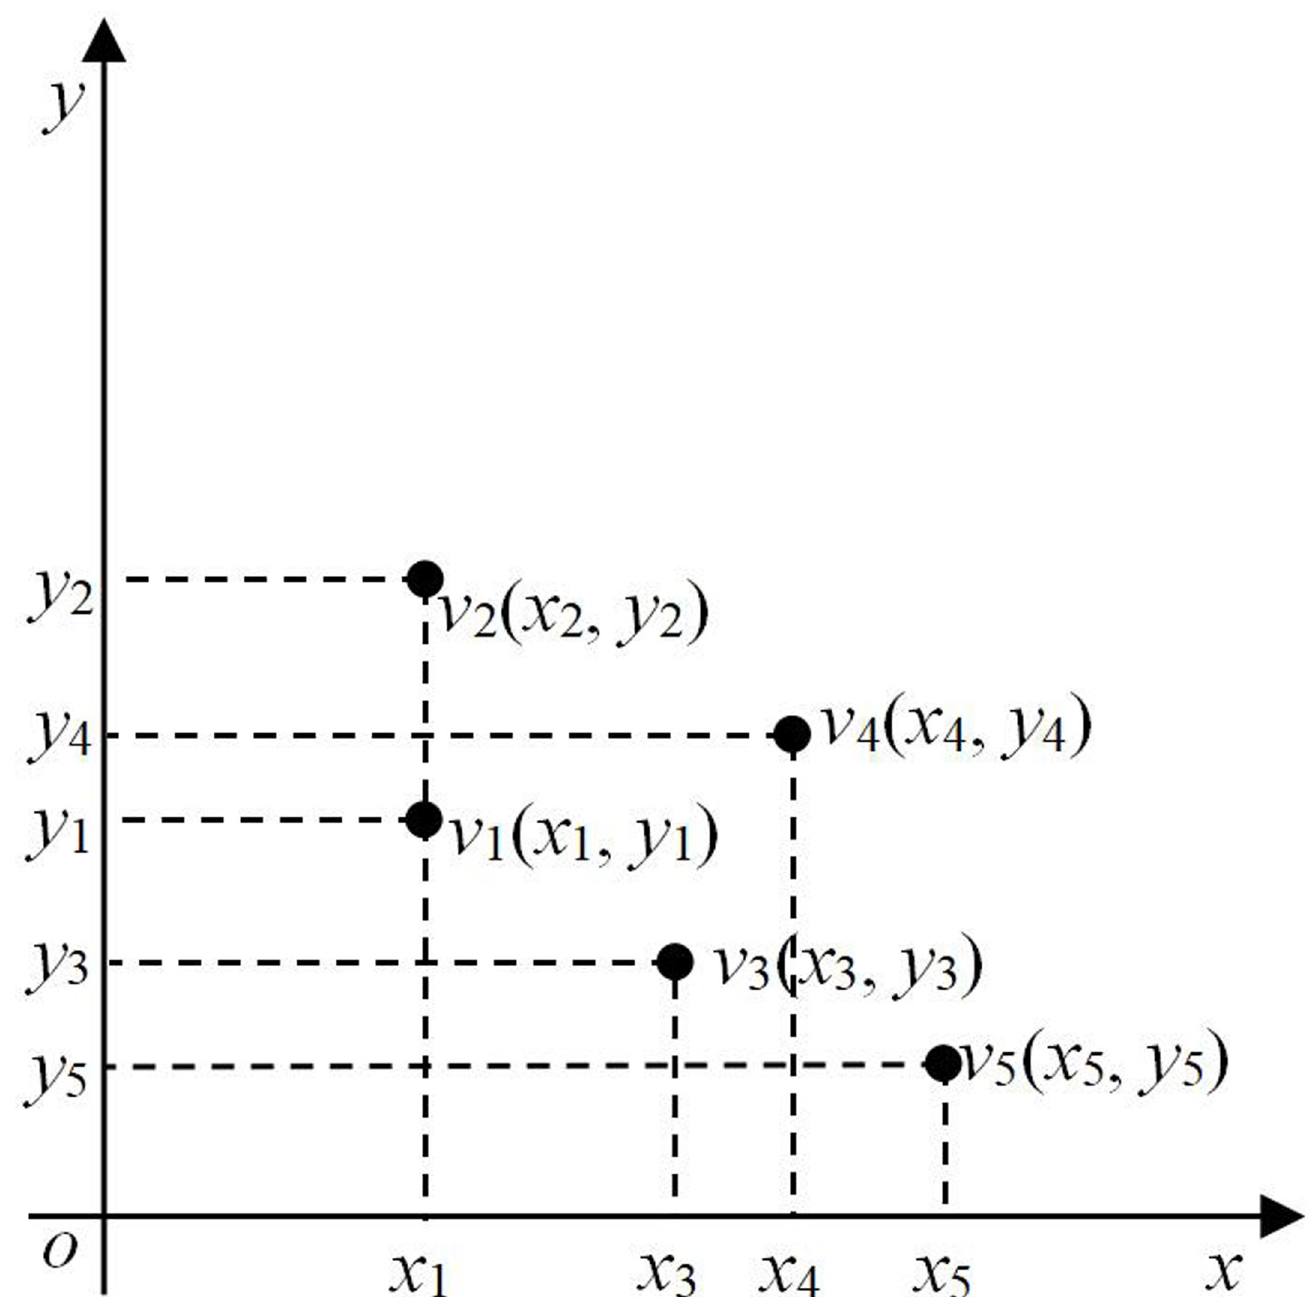
Fig 4. Coordinate axes